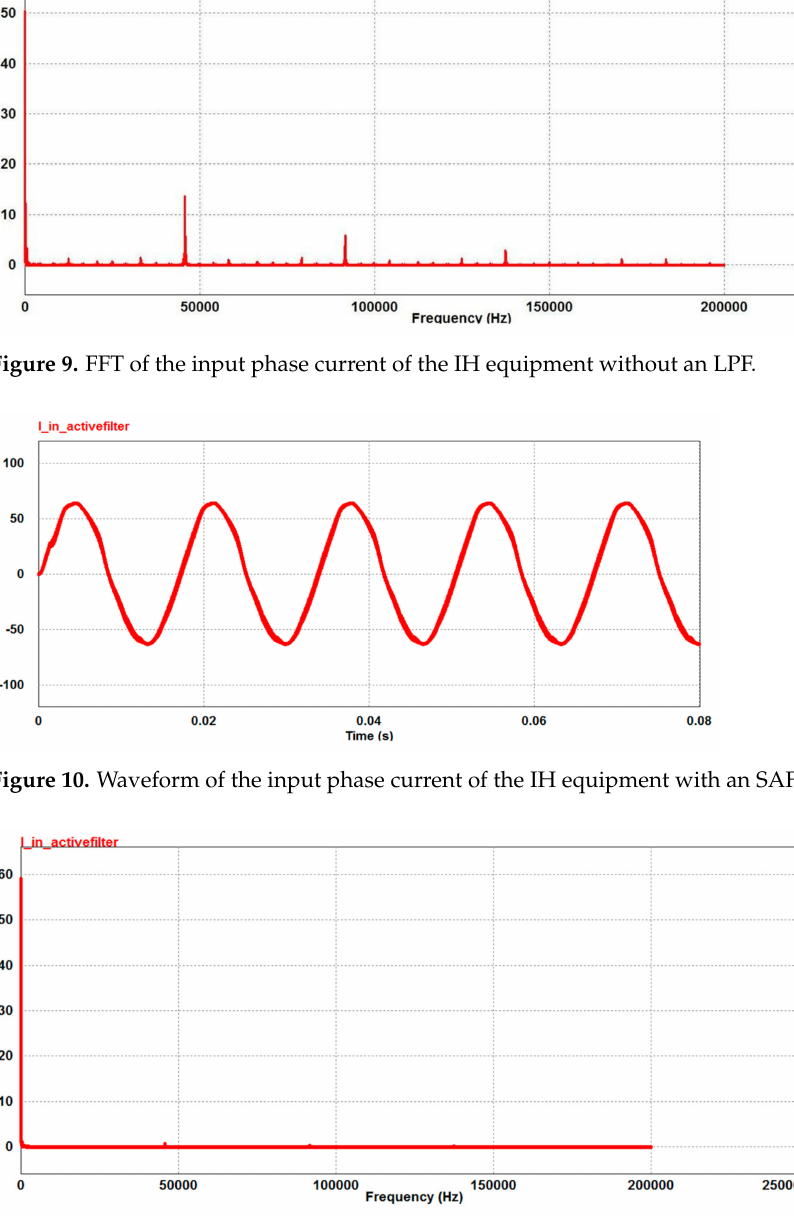
Figure 11. FFT of the input phase current of the IH equipment with an